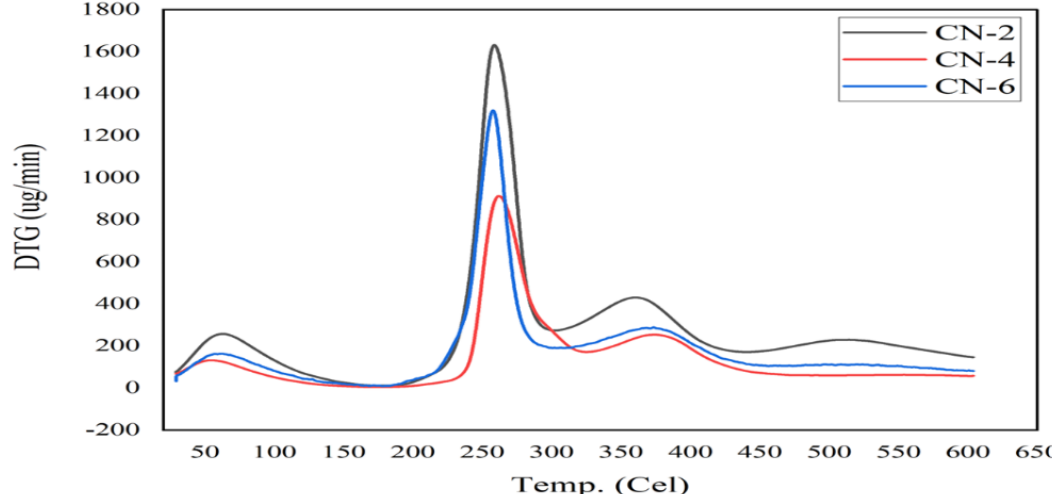
Figure 8. Thermal analysis: DTG curve of jute CNC samples for CN-2, CN-4, and CN-6. Table 3. Different thermal parameters for samples from TGA and DTG